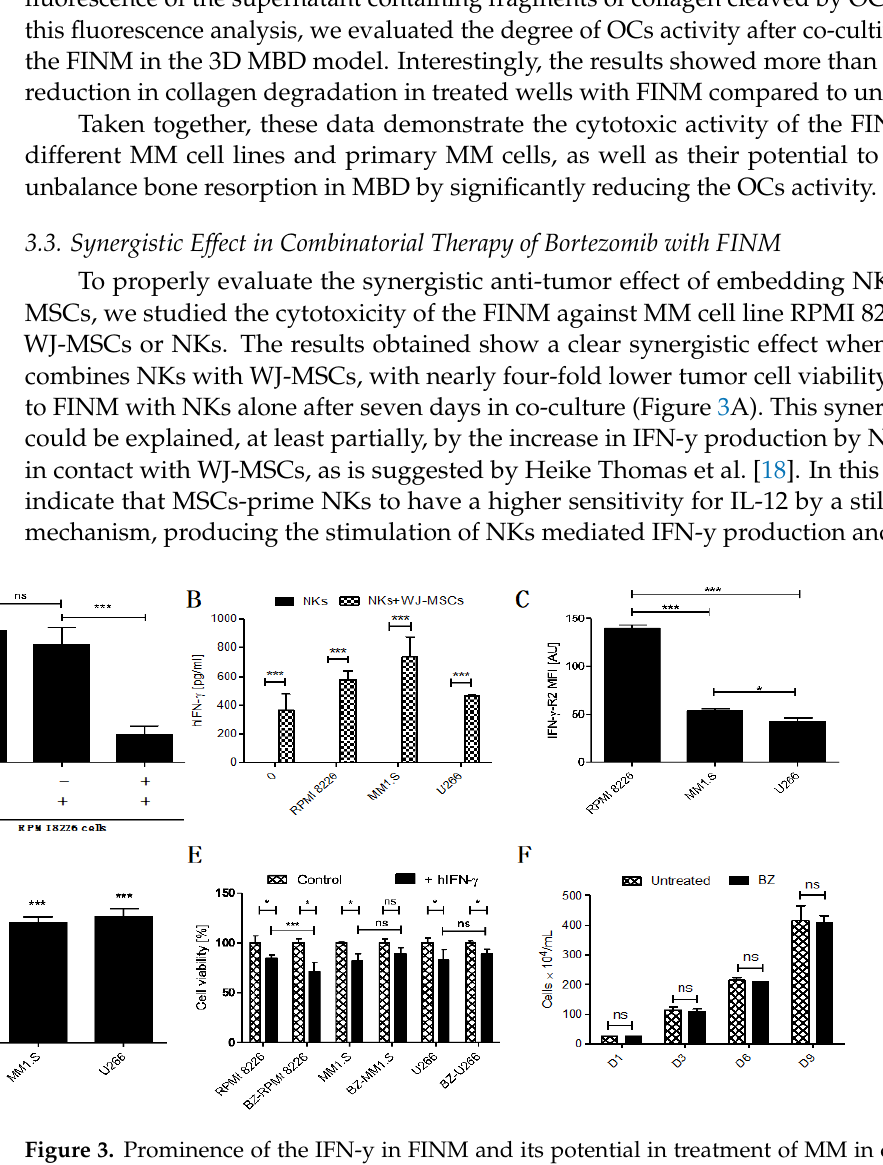
Figure 3. Prominence of the IFN-y in FINM and its potential in treatment of MM in combination with BZ. ( A ) Viability of RPMI 8226 cells after 7-day co-culture with FINM prototype containing WJ-MSCs/NKs/combination. ( B ) IFN-y produced by NKs in seven day co-culture with MM cell lines +/ − WJ-MSCs in fibrin covered with culture medium. ( C ) Mean IFN-y-R2 expression per cell (MFI) in RPMI 8226, MM1.S and U266. ( D ) Fold change in mean IFN-y-R2 expression per cell (MFI) in RPMI 8226, MM1.S and U266 cells in culture with BZ. ( E ) hIFN-y effect on cell viability of the BZ-pretreted (BZ-) and not pretreated MM cells (RPMI 8226, MM1.S and U266). ( F ) RPMI 8226 cell line growth in culture with/without BZ (nine days). Data in ( A – F ) are presented as means ± SD from three technical replicates. ns—not significant; * − p < 0.01; *** − p < 0.001; one-way ANOVA, repeated measures test and Student’s t